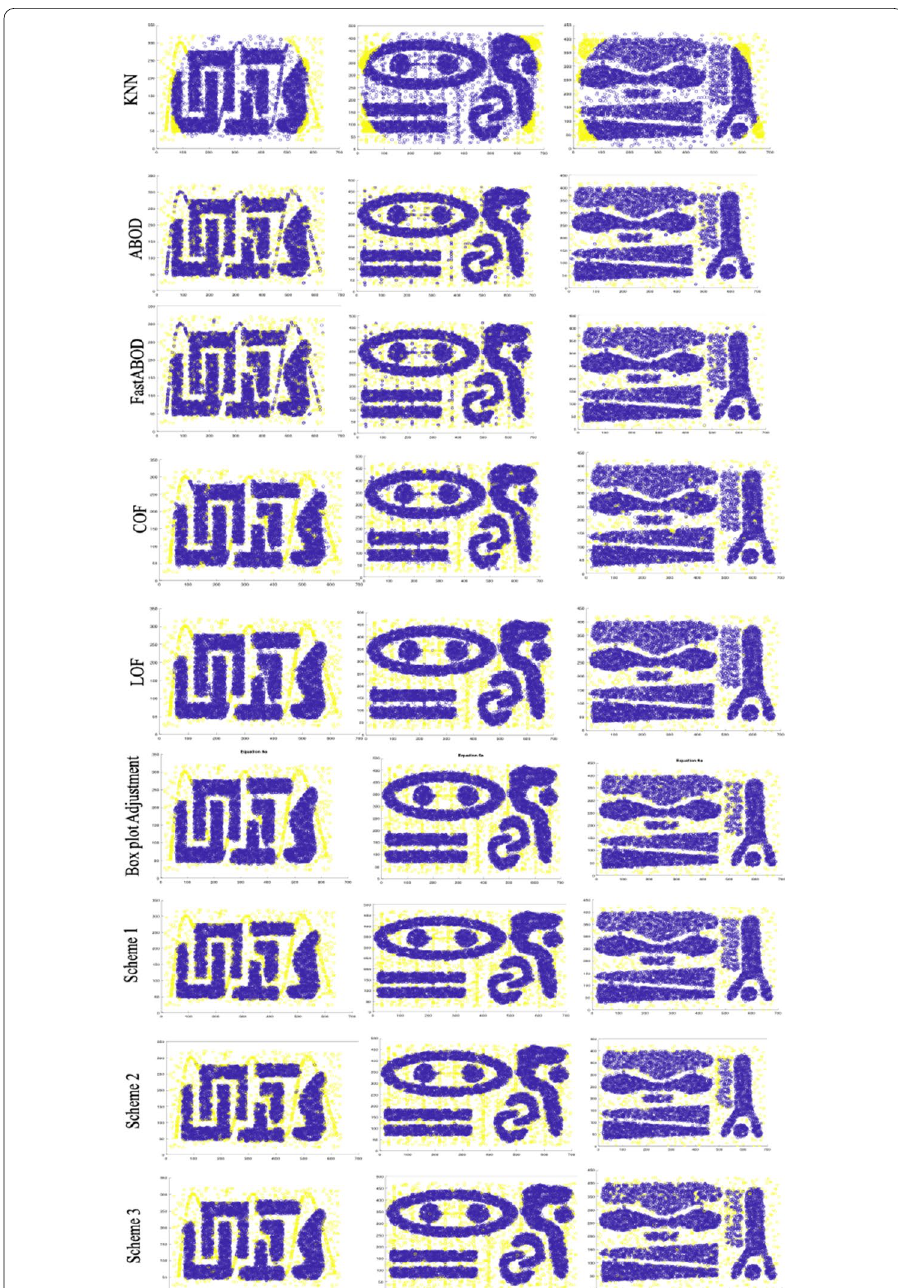
Fig. 14 Visual comparison for outlier detection using three synthetic datasets. Row 1–5: state-of-art methods and Row 6–9: the newly proposed